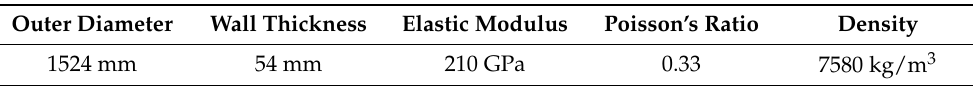
Table 2. Parameters of model pipe piles. Outer